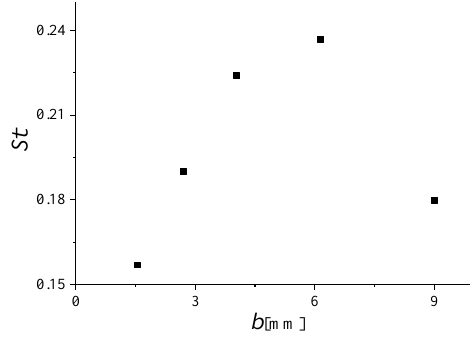
Figure 16. Change in 𝑆 𝑡 with various values of b.